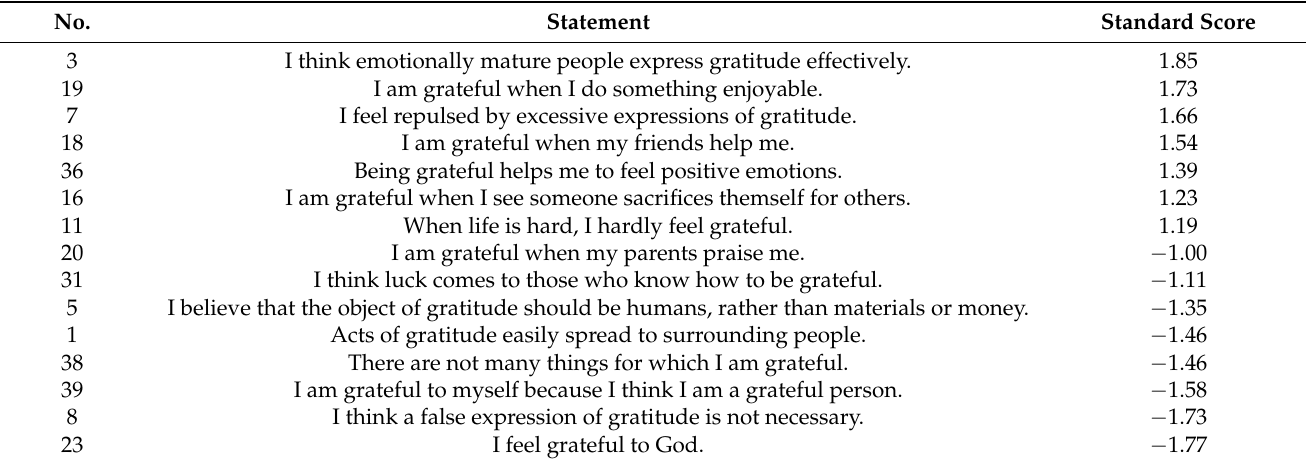
Table 11. Statements and standard scores (at least ± 1.00) of type 5.